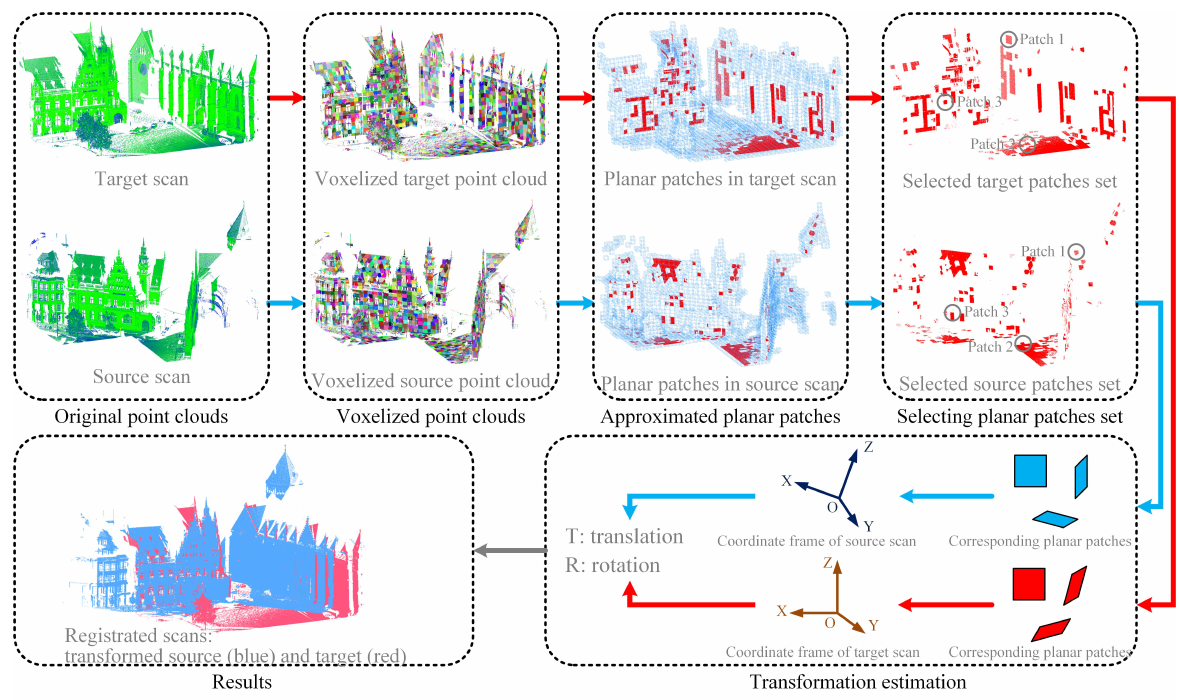
Figure 1. Workflow of the proposed coarse registration